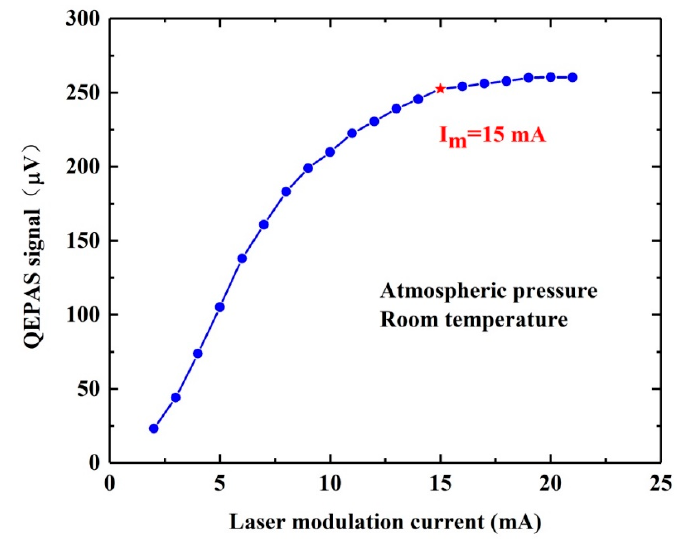
Figure 6. The QEPAS signal amplitude as a function of laser modulation current.